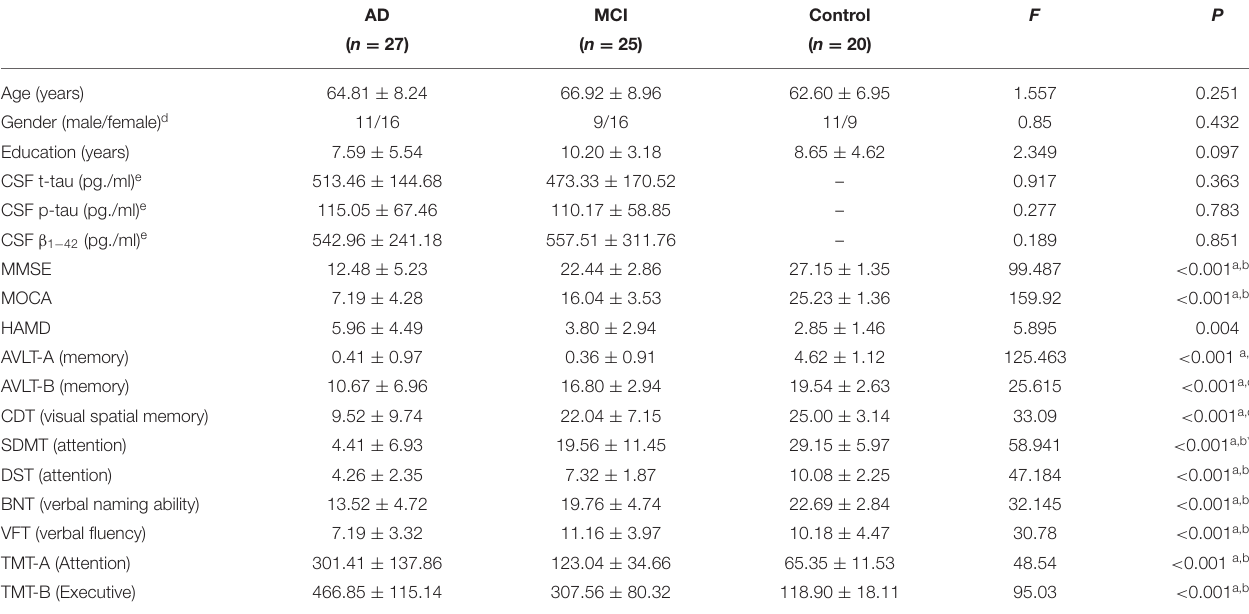
TABLE 1 | Demographic and clinical characteristics of the participants. AD MCI Control F